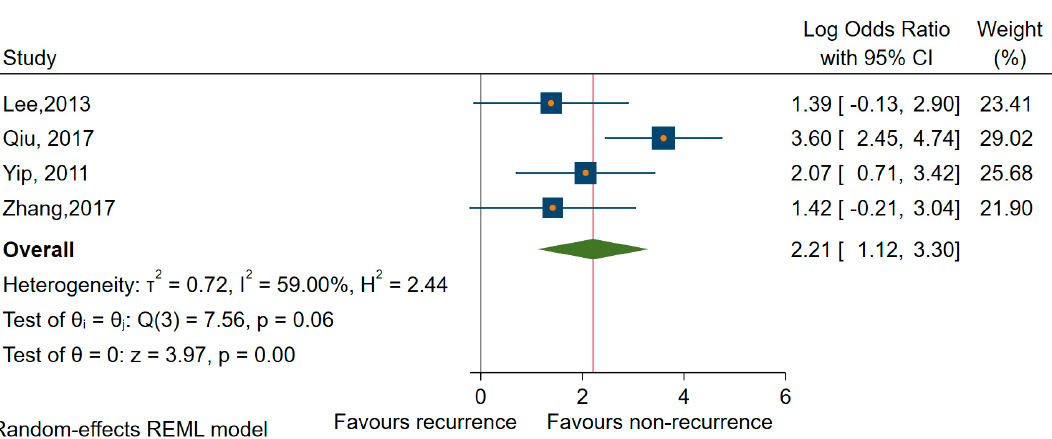
Figure 9. Forest plot of the association between miR-221/222 cluster expression and recurrence.